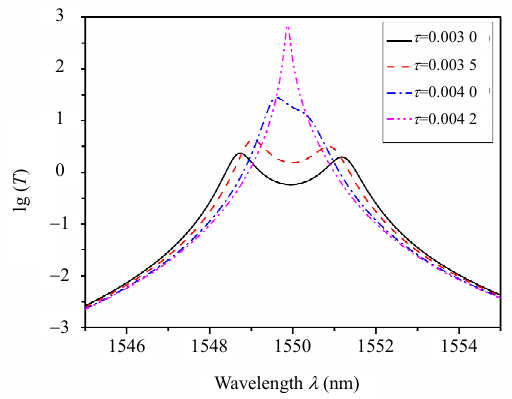
Fig. 3 Transmission spectra of the structure in Fig. 1 with different  .